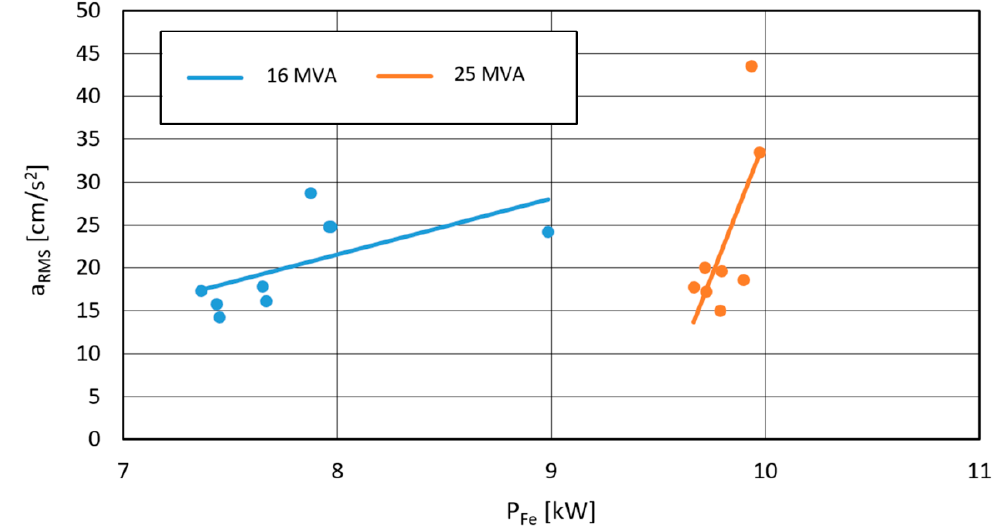
Figure 11. Dependence of the average root mean square value of vibration acceleration on the value of no-load losses (P Fe ) of 16 and 25 MVA transformers.